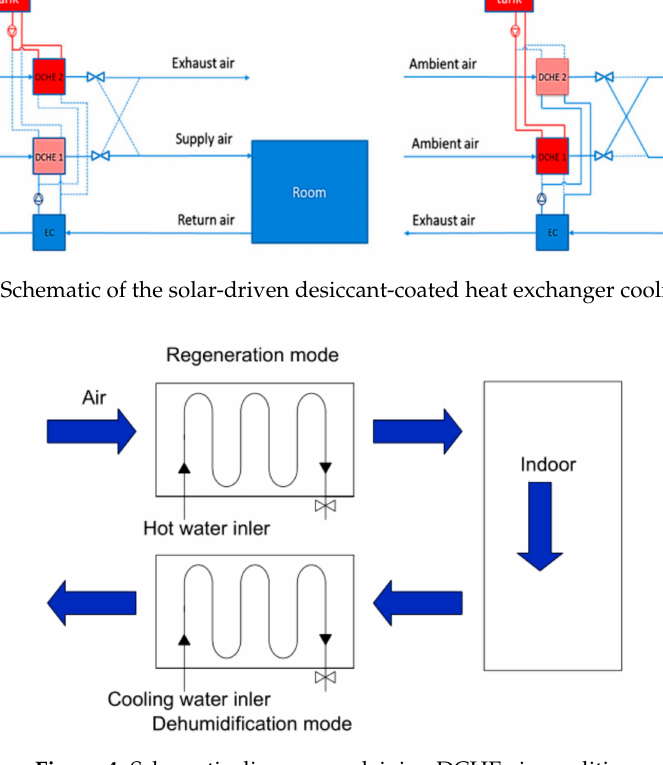
Figure 4. Schematic diagram explaining DCHE air conditioners in winter